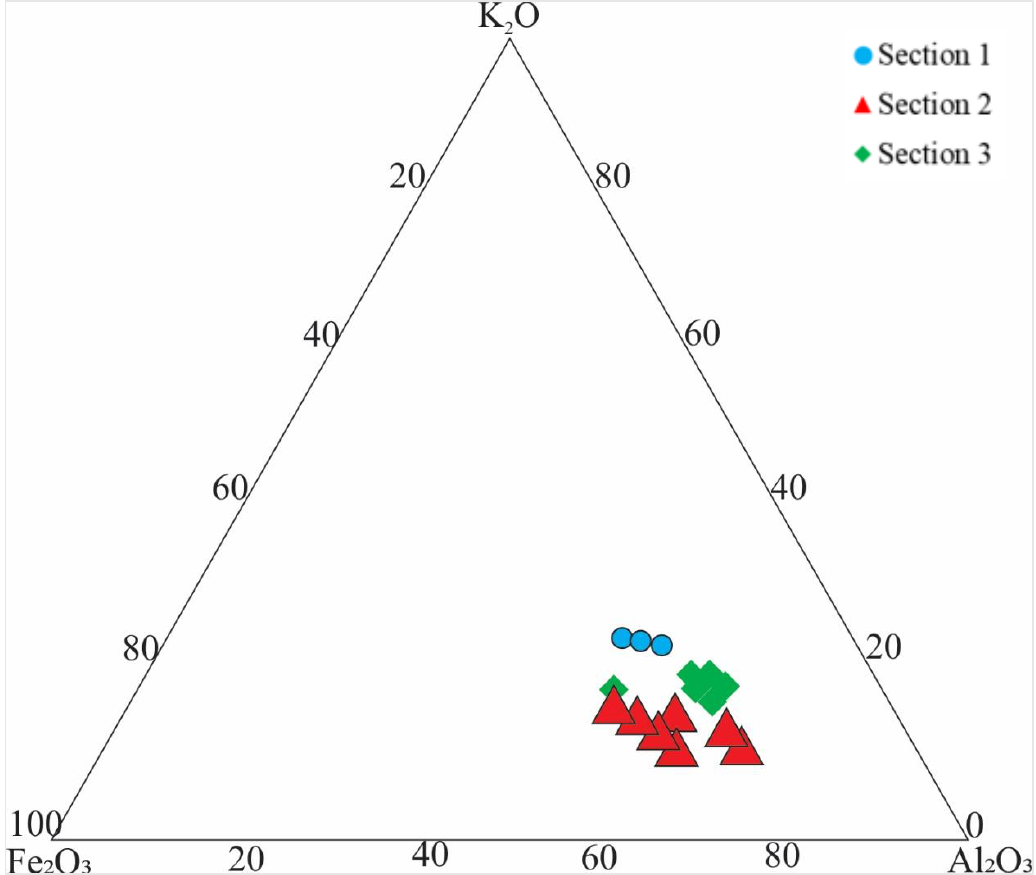
Figure 6. Ternary K 2 O – Fe 2 O 3 – Al 2 O 3 diagram for Chichali Formation shale.